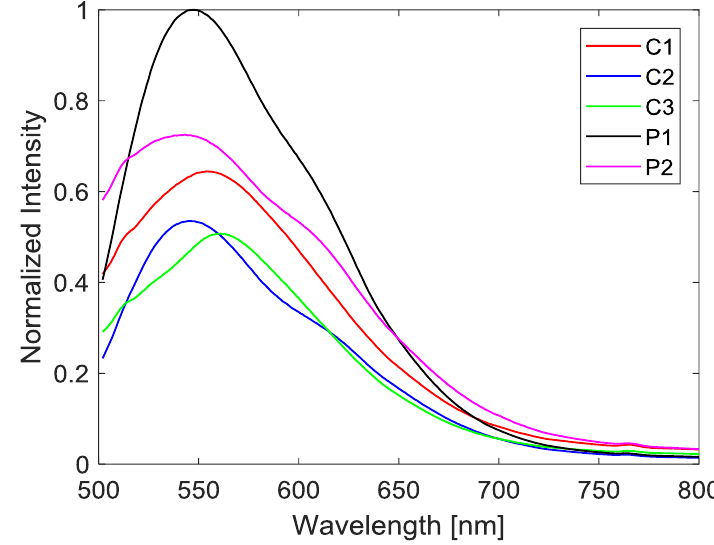
Figure 3. Spectral output of different PF resin samples at 300 K, normalized by the maximum intensity of the brightest sample, P1.